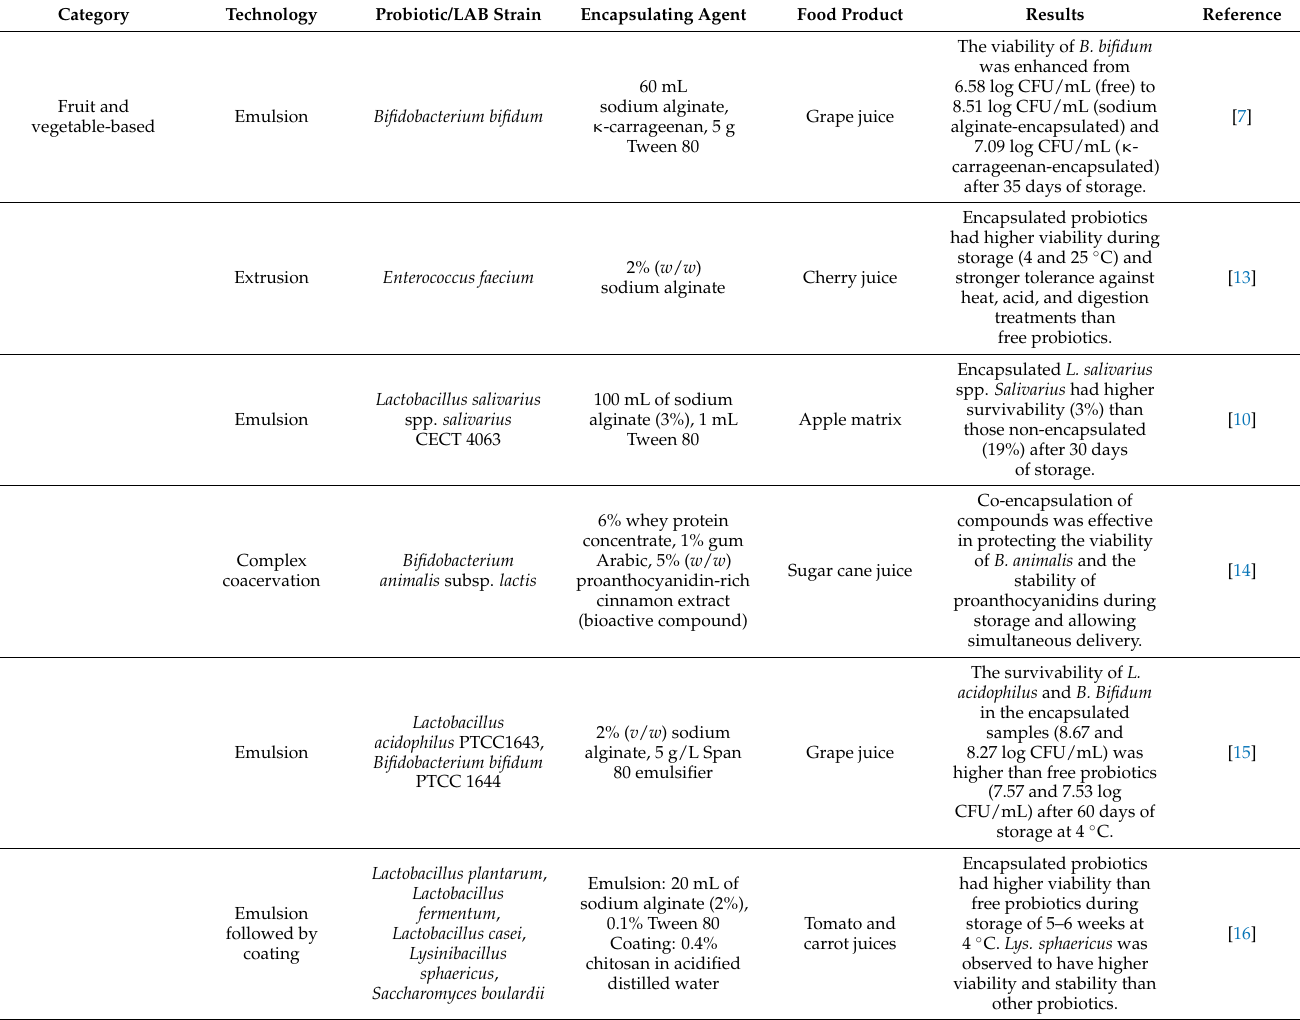
Table 3. Examples of recent application of probiotics encapsulation in non-dairy-based